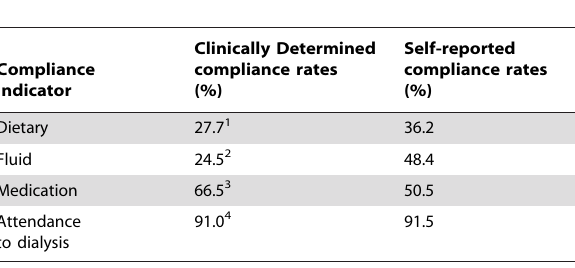
Table 2. Comparison between clinically determined and self- reported compliance